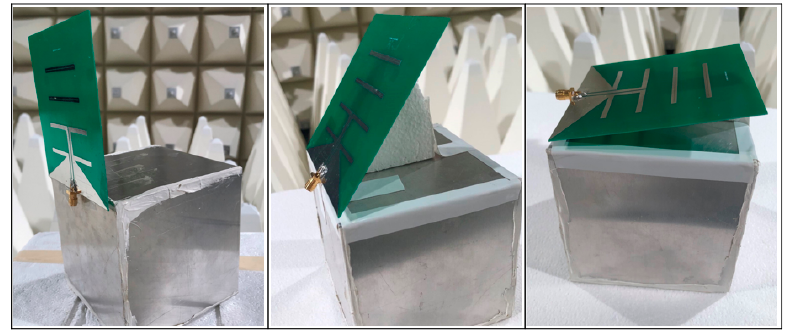
Figure 4. Fabricated antenna on 1U Cube with various lift angle.